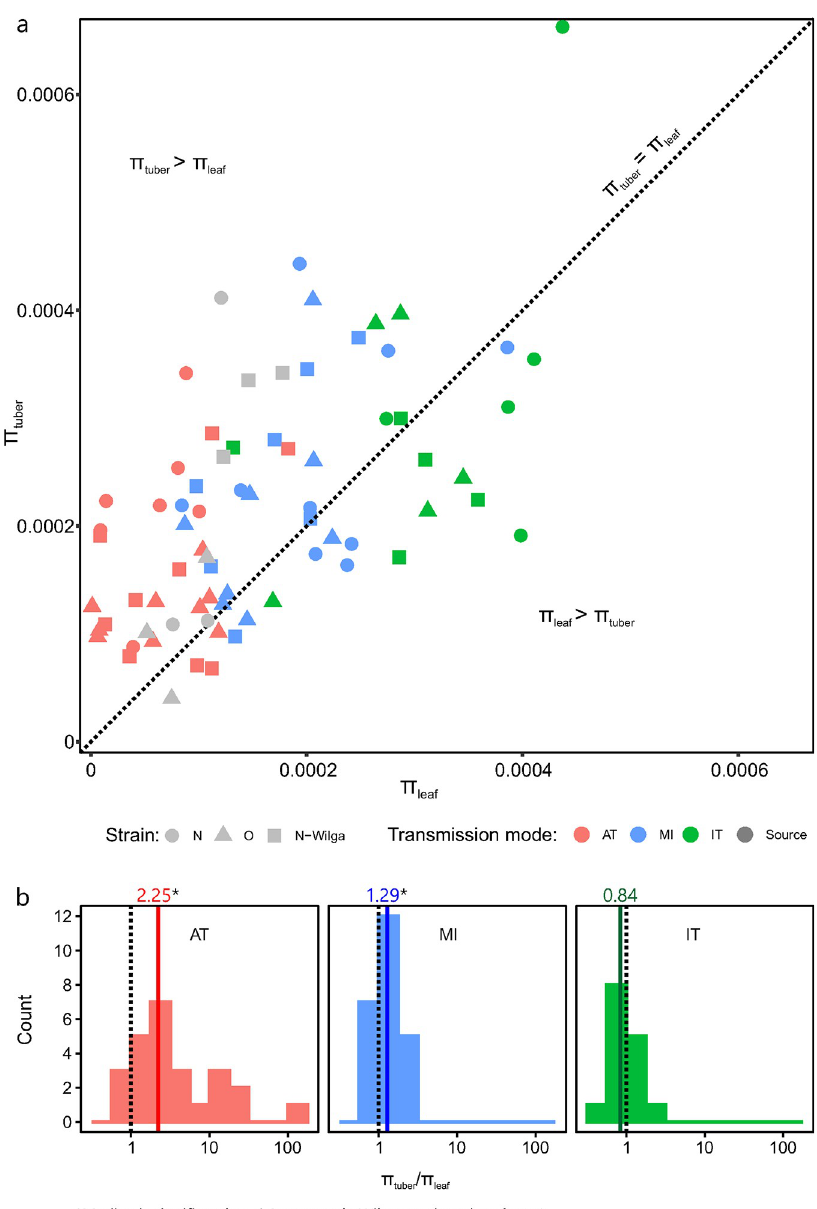
Fig 3. Comparison of nucleotide diversities ( π ) in leaves and tubers. (a) π in leaves (abscissae) are plotted against π in tubers (ordinates) for the same plants. Different colors represent different transmission modes, different symbols represent different strains. (b) Histograms show distributions of decimal log-transformed ratios of nucleotide diversities in tubers and leaves; dotted lines designate the null hypothesis of equal diversities π tuber / π leaf = 1, colored lines represent medians of the separate distributions. Colors correspond to the different transmission modes as given in the legend above the histograms. genome units that were transmitted from one to the other passage. We compared the viral populations in systemically infected leaves of source and inoculated plants, thus estimating N values for the whole transmission process (including transmission event itself, as well as the movement of the virus from the inoculated leaf to the systemically infected leaf). We observed